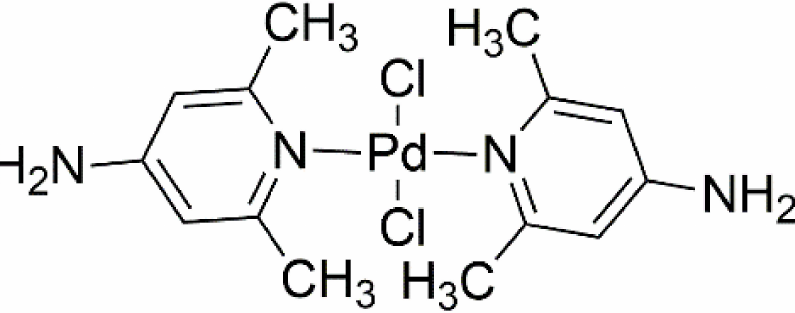
Figure 20. Structure of palladium derivative conjugated with 2,6-dimethyl-4-nitro-pyridine